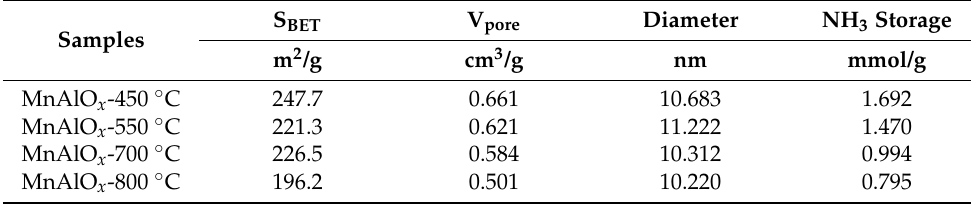
Table 1. BET surface area and NH 3 storage of MnAlO x -T catalysts.